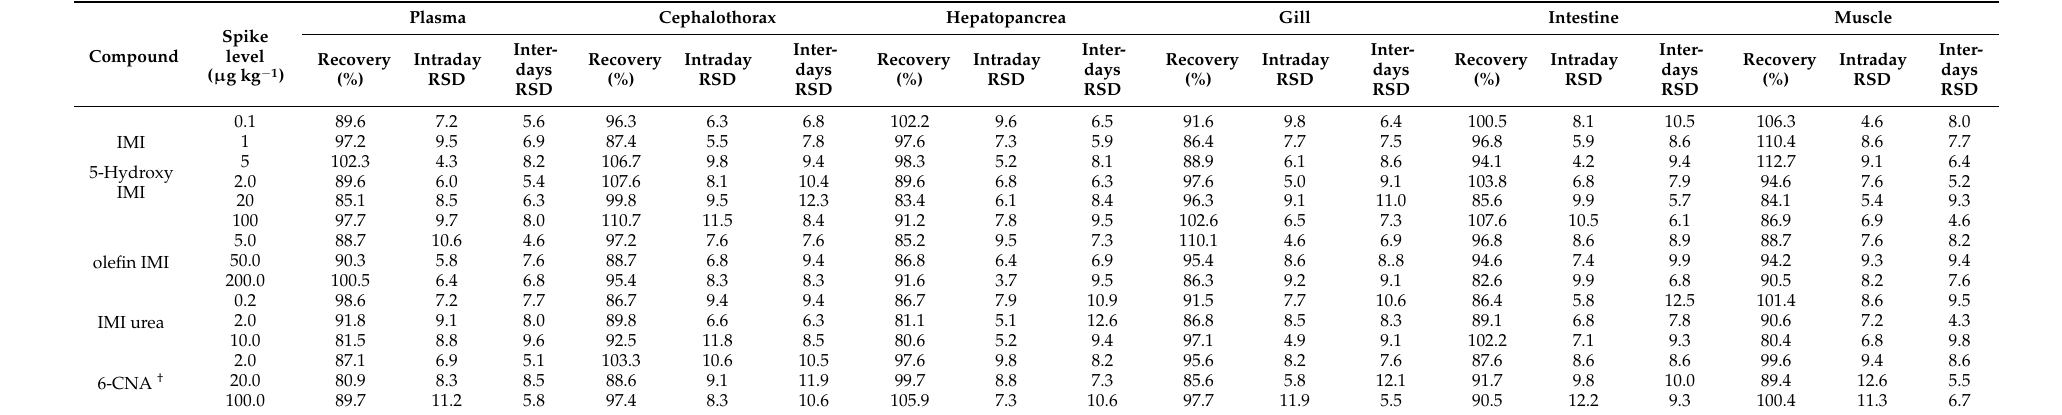
Table 4. Recoveries and RSDs from spiked samples ‡